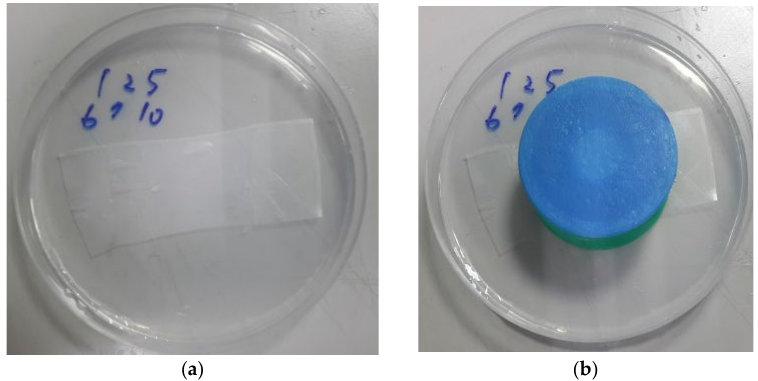
Figure 12. ( a ) agar matrix covered with parafilm and ( b ) CGMS penetration into agar matrix.